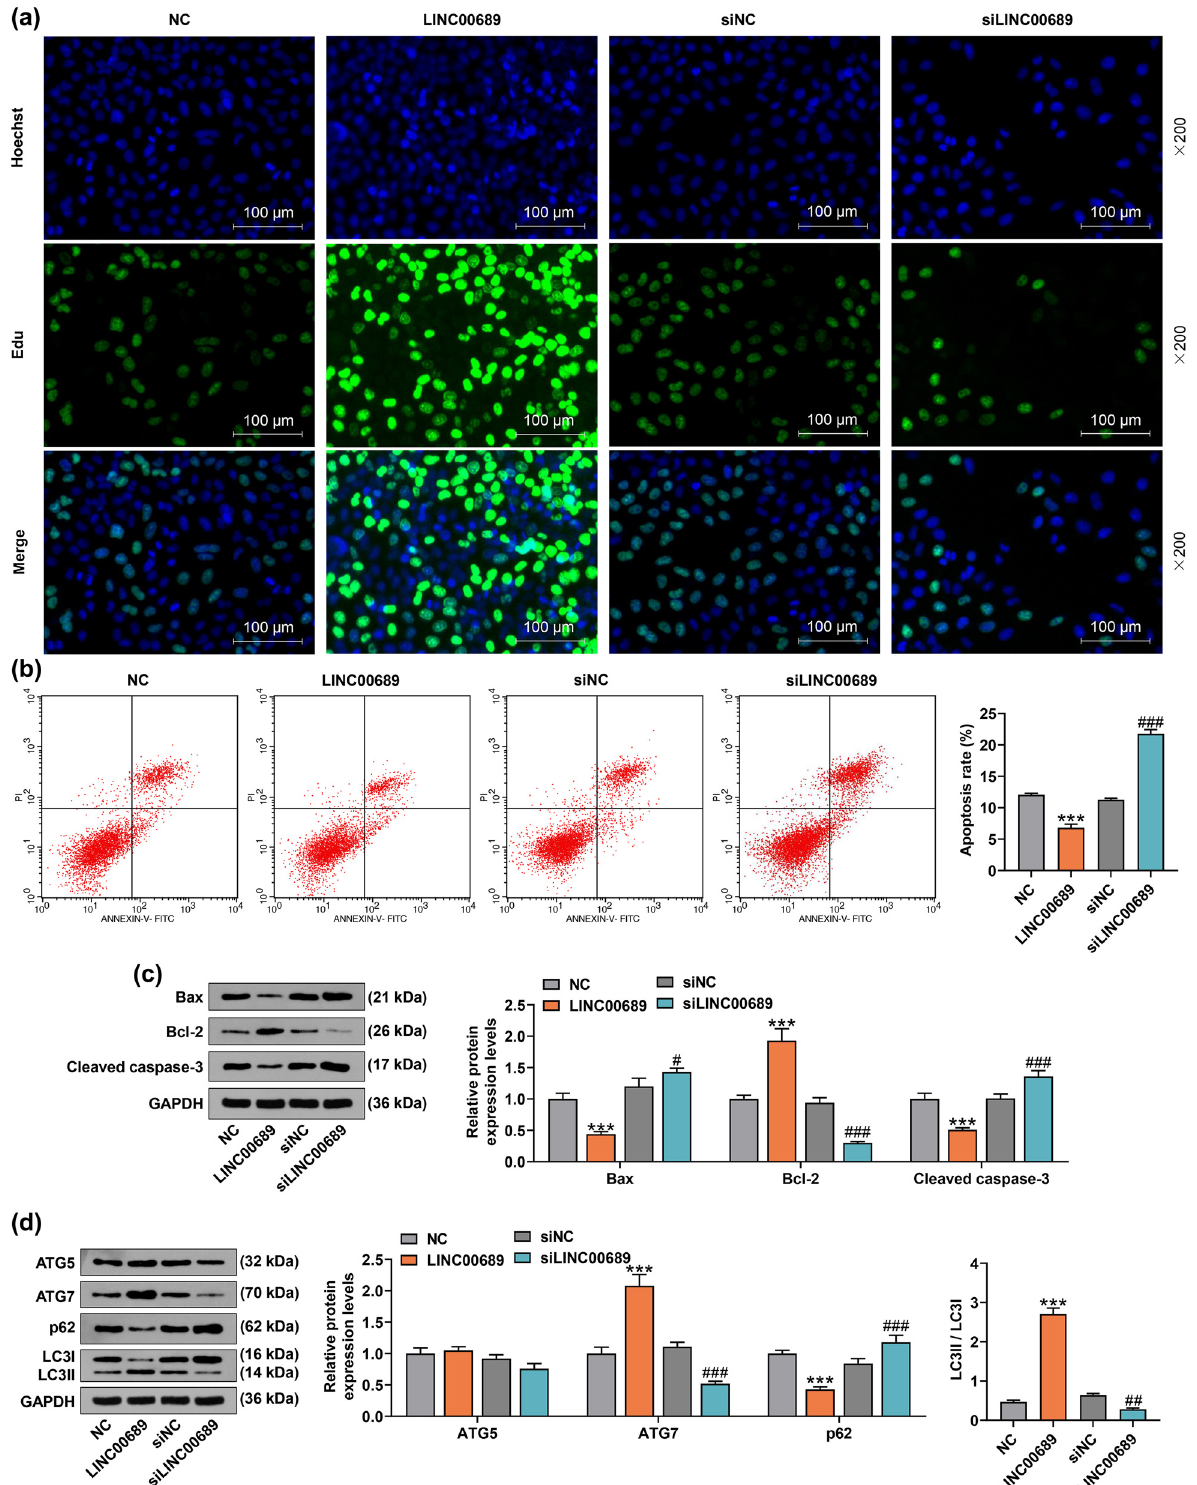
Figure 2: Overexpressed LINC00689 promoted the proliferation and autophagy yet inhibited the apoptosis of NPCs, whereas siLINC00689 did the opposite. ( a ) The proliferation of NPCs was measured by EdU staining after NPCs were transfected with LINC00689 overexpression plasmid or siLINC00689 ( under 200 × magni fi cation, scale bar = 100 μ m ) . ( b ) The apoptosis of NPCs was detected by fl ow cytometry. ( c ) The expressions of apoptosis - related factor ( Bax, Bcl - 2, and Cleaved caspase - 3 ) in transfected NPCs were examined using the Western blot. ( d ) The levels of autophagy - related proteins ( ATG5, ATG7, p62, and LC3 Ⅱ /LC3I ) in transfected NPCs were analyzed by the Western blot. *** P < 0.001 vs NC; # P < 0.05, ## P < 0.01, ### P < 0.001 vs siNC ( LINC00689: long non - coding RNAs LINC00689, NPCs: human nucleus pulposus cells, siLINC00689: small interfering RNA speci fi cally targeting LINC00689, NC: negative control, ATG7: autophagy related 7 )